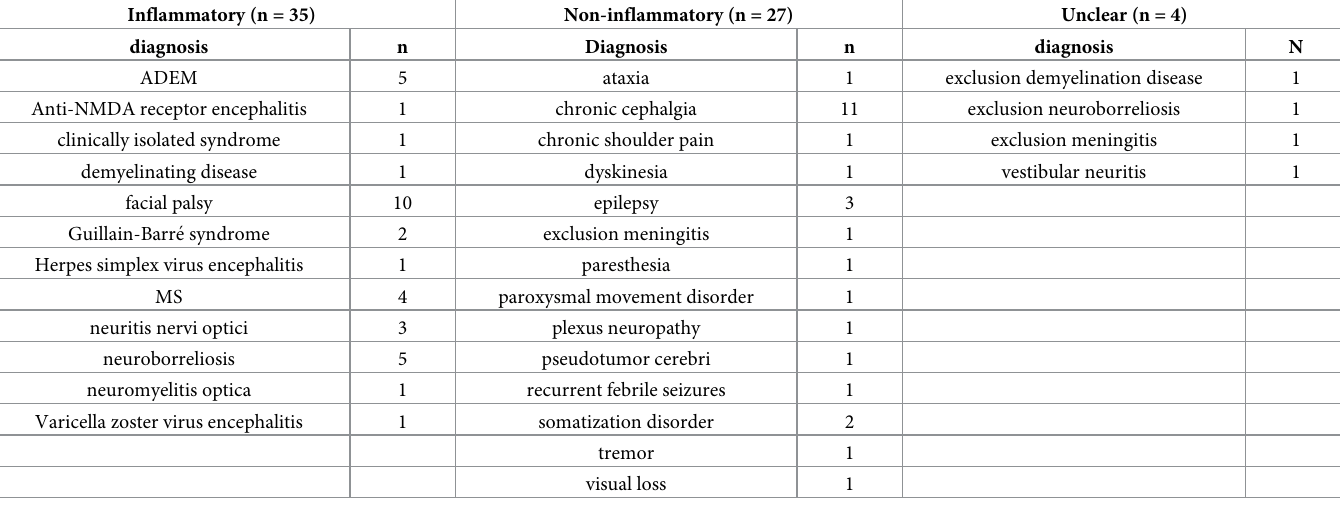
Table 2. Clinical diagnoses of samples for measurement of fetuin-A in CSF and serum with ELISA. Inflammatory (n =